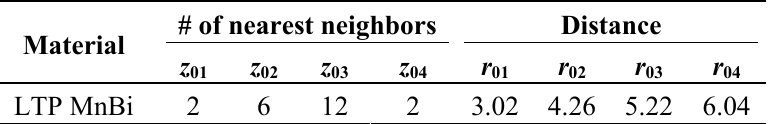
Table 2. The number of nearest neighbors ( z of Å in LTP